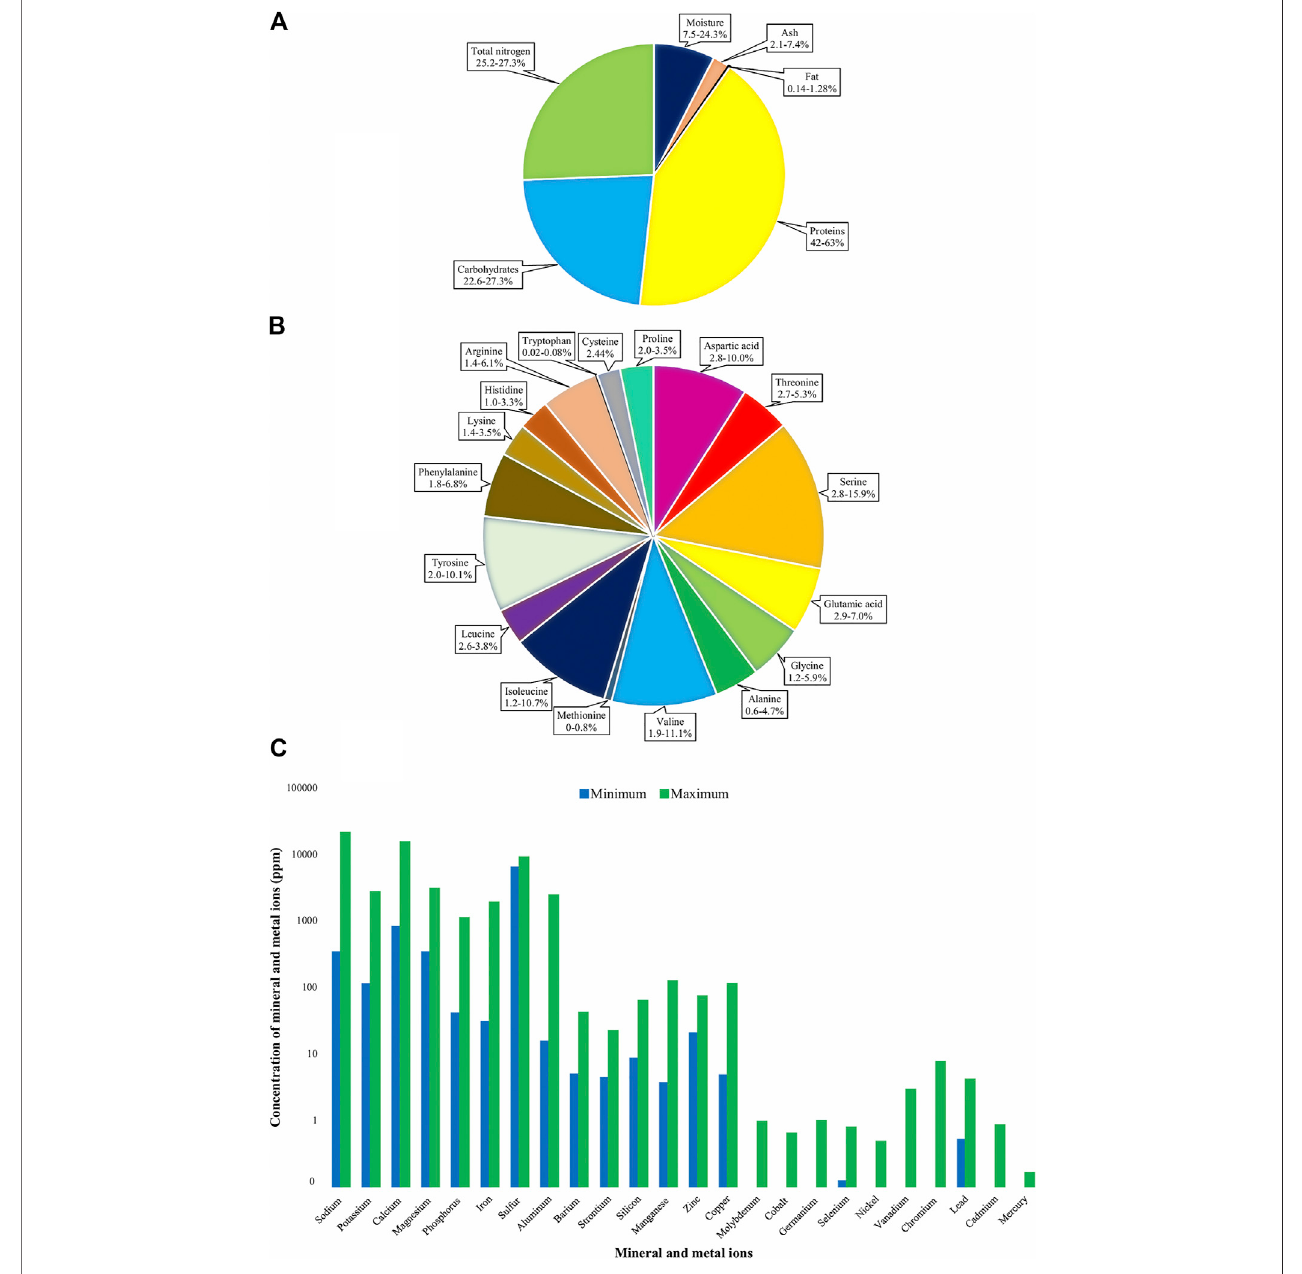
FIGURE 3 | Total composition (A) , amino acid (B) , mineral and metal ions (C) in EBN (Marcone, 2005; Ma and Liu, 2012).